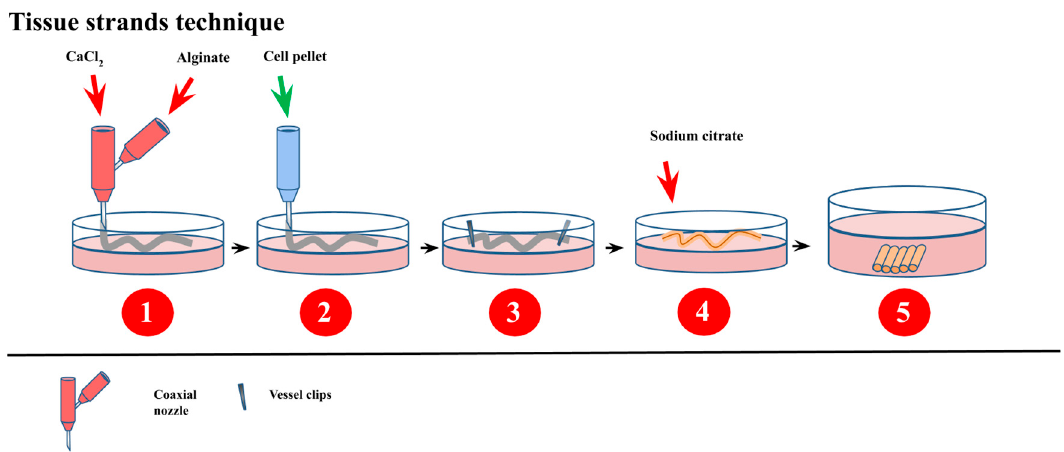
Figure 4. Schematic description of the tissue strands technique based on the ability of the cells to self-assemble into a tissue. Sodium alginate and a crosslinker solution are used to form tubular alginate capsules with a coaxial nozzle into a cell culture dish. Once polymerized, the capsules are filled with a cell pellet, and their ends are tightly sealed with vessel clips. After a 5–7 day culture, a sodium citrate solution is added to depolymerize the capsules, leaving complete and dense tissue strands that can later be used as building blocks to form complex larger tissues [186].